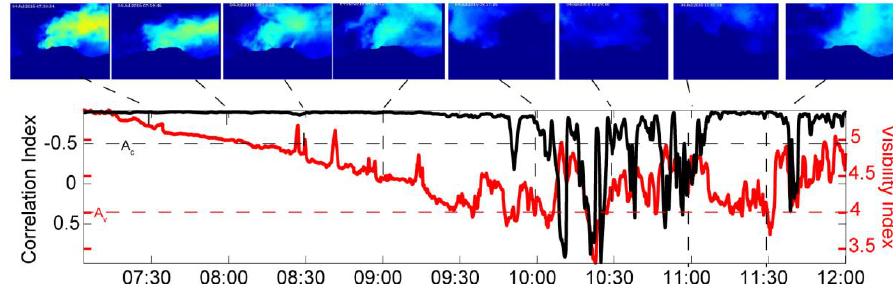
Figure 4. Example of output of the quality indexes sub-routine. The visibility (fog) and correlation indexes fluctuate through time as visibility conditions change (see snapshots on top of the figure). Gas is visible only when the fog index is greater than 4 and the correlation index is less than -0.5.